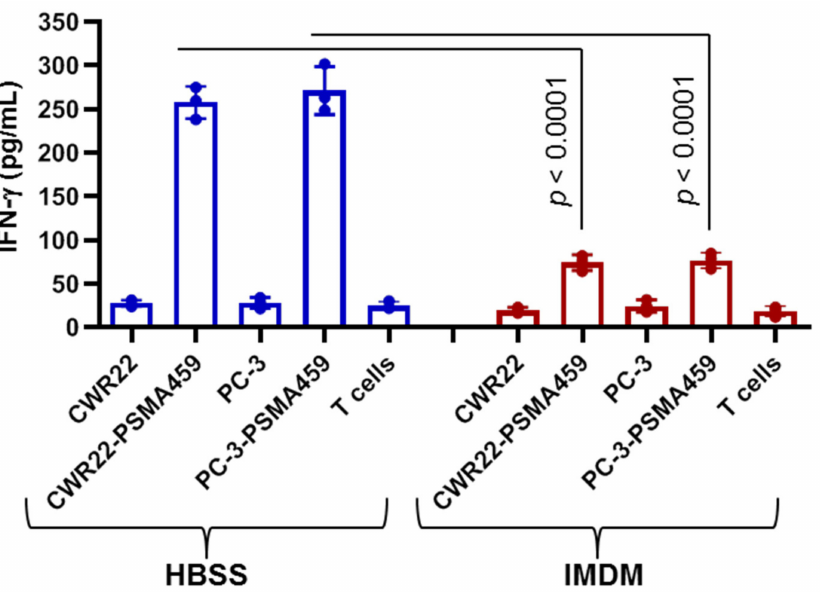
Figure 6. Cysteinylation of the PSMA459 peptide reduces CD4 + T cell recognition of prostate cancer cells. HLA-DR4-expressing CWR22Rv1.DR4 and PC-3.DR4 cells were incubated with the PSMA 459–473 peptide (20 µ m) in either HBSS buffer or IMDM media overnight at 37 ◦ C and were washed and fixed with 1% paraformaldehyde. Cells were washed again and were cocultured with the PSMA 459–473 peptide-specific CD4 + T cells for 48 h. The production of IFN- γ was quantitated using ELISA and expressed as pg/mL as described. Data are representative of three separate experiments.